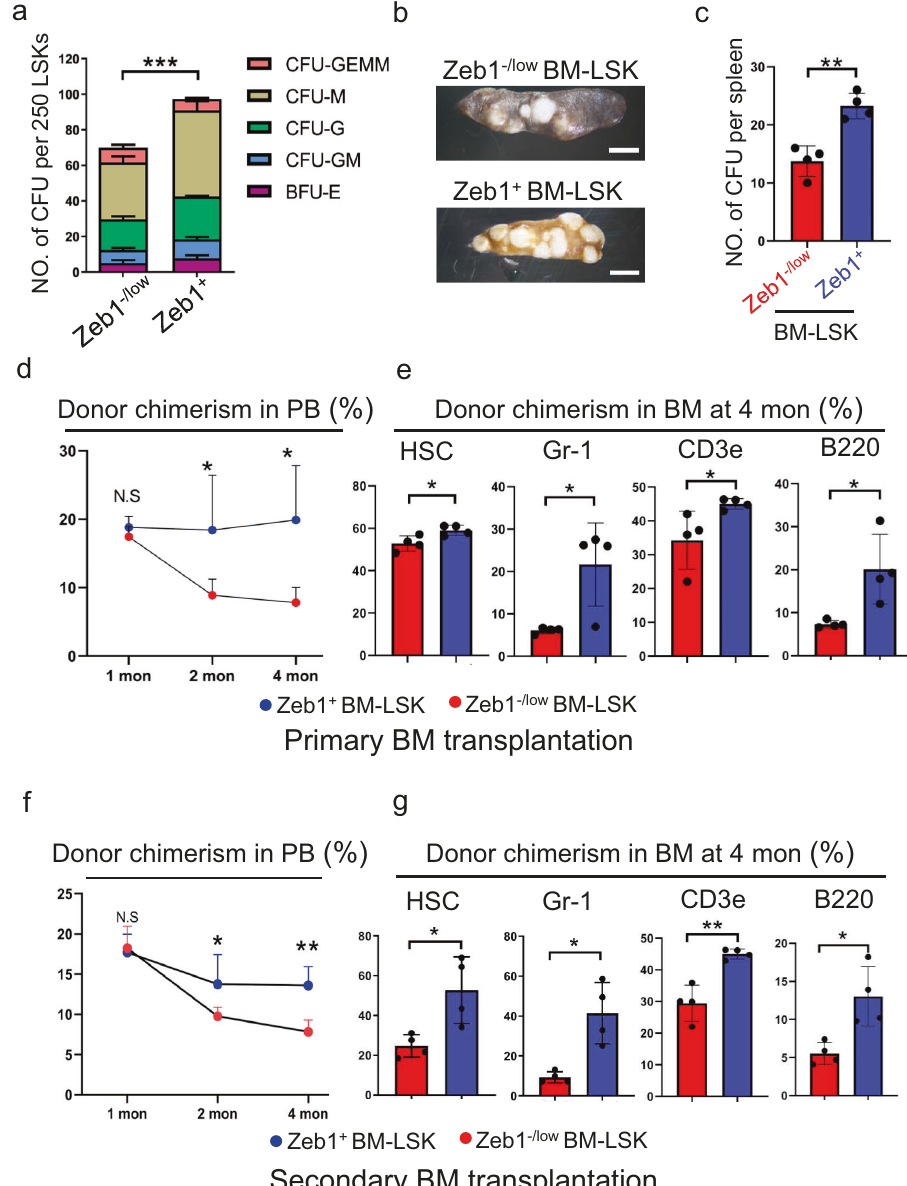
Fig. 2 Zeb1 + -LSKs exhibit stronger stem cells-activity than their Zeb1 -/low counterparts. a The in vitro CFU assay showing the colony numbers of BFU-E, CFU-GM, CFU-G, CFU-M, and CFU-GEMM derived from 250 Zeb1 − /low and Zeb1 + -LSKs. BFU-E: burst-forming unit- erythrocyte; CFU-E CFU- erythrocyte, CFU-G CFU-granulocyte, CFU-M CFU-macrophage, CFU-GEMM CFU-granulocyte, erythrocyte, macrophage, megakaryocyte. *** P < 0.0001. b, c The in vivo CFU-spleen (CFU-S) assay showing splenic nodules derived from Zeb1 − /low and Zeb1 + -LSKs ( b ). Quanti fi cation results from 4 Zeb1-tdTomato reporter mice were presented ( c ). ** p < 0.001. d The donor chimerism curves showing the blood reconstitution contributed by Zeb1 − /low and Zeb1 + -LSK donor cells in PB at indicated time points in the primary BM transplantation. * p < 0.01, N.S no signi fi cance. e Chimerism contributed by Zeb1 − /low and Zeb1 + -LSK donor cells from BM showing the multilineage reconstitution potential in the PB, including HSC (CD150 + CD48 − LSK); myeloid cells (Gr-1 + ); T cell (CD3e + ) and B cell (B220 + ) were determined. Data are represented as mean ± SD. * p < 0.01; ** p < 0.001; *** P < 0.0001. f The donor chimerism curves showing the blood reconstitution contributed by Zeb1 − /low and Zeb1 + -LSK donor cells in the PB at indicated time points in the secondary BM transplantation. Data are represented as mean ± SD. * p < 0.01; ** p < 0.001, N.S no signi fi cance. g Chimerism contributed by Zeb1 − low and Zeb1 + -LSK donor cells in BM showing the multilineage reconstitution potential of Zeb1 − /low and Zeb1 + -LSKs including HSC (CD150 + CD48 - LSK), myeloid cells (Gr-1 + ), T cell (CD3e + ), and B cell (B220 + ). Data are represented as mean ± SD. * p < 0.01; ** p < 0.001. signi fi cantly enriched in the Zeb1 − /low versus Zeb1 + -LSKs (Fig. 4b). FASC-sorted Zeb1 + and Zeb − /low -LSKs. The differentially expressed genes (DEGs) were identi fi ed in the Zeb1 − /low versus Consistent with the lower ROS and OXPHOS signatures in the Zeb1 + -LSKs, a gene set enrichment analysis (GSEA) revealed Zeb1 + -LSKs (Fig. 4a). A Gene Ontology (GO) analysis of the upregulated genes demonstrated that ROS, electron transport decreased ROS hallmarks in the Zeb1 + -LSKs (Fig. 4c). To validate chain (ETC), and OXPHOS-related biological processes were most these results, we assessed the intracellular ROS levels in Zeb1 − /low